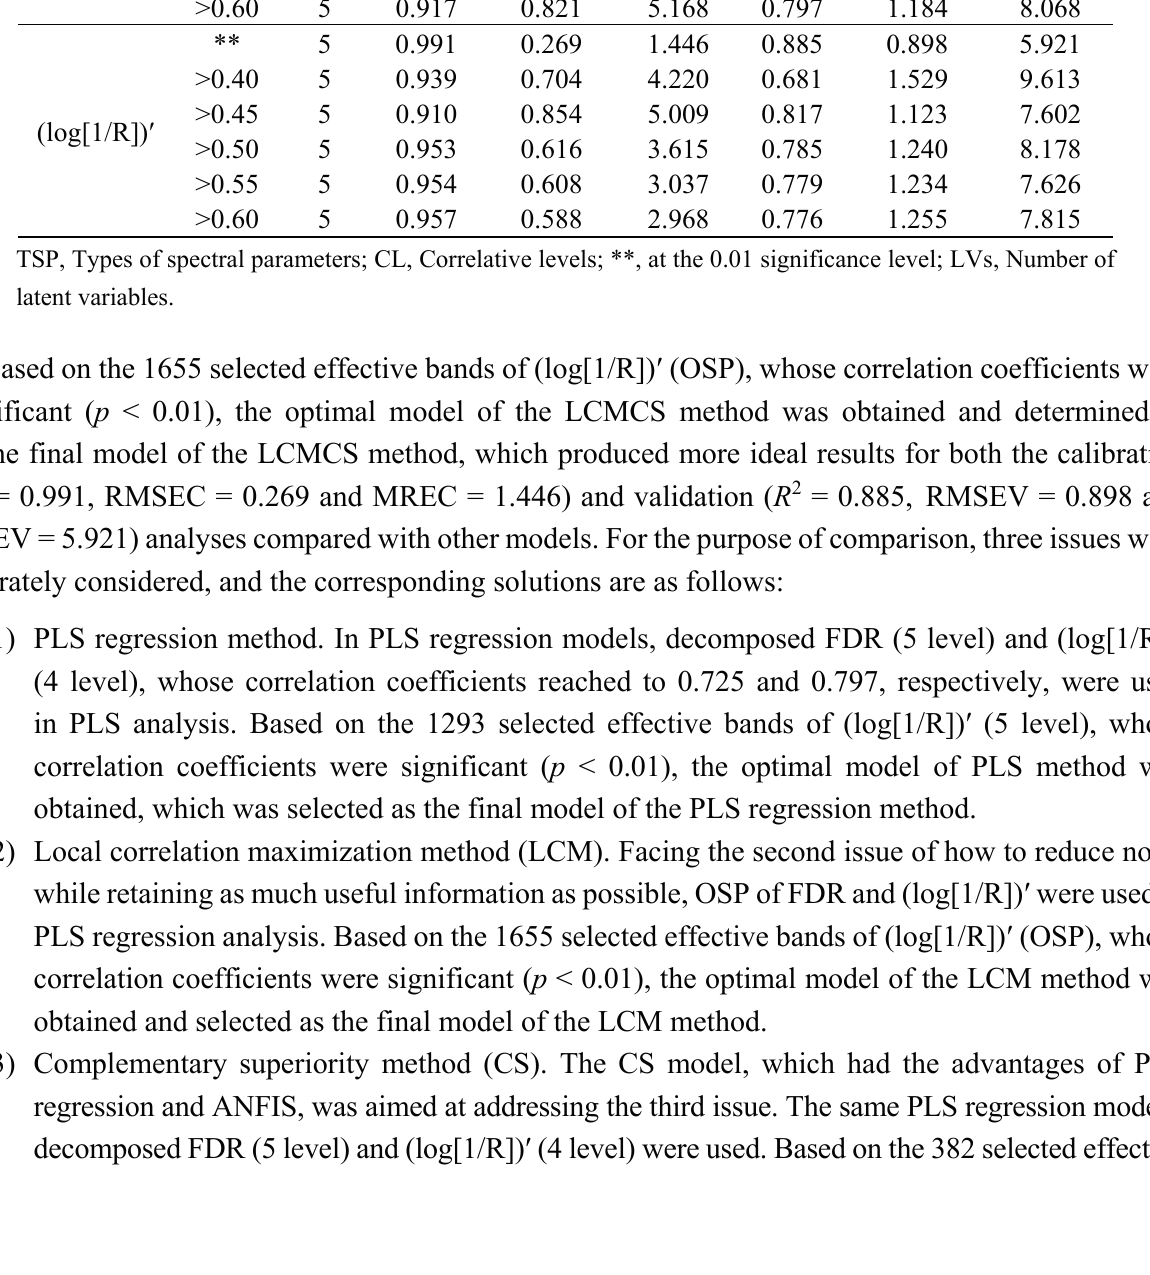
Table 6. Comparisons of the performance of models established by the local correlation maximization-complementary superiority method at different correlative levels of the first derivative differential (FDR (optimal spectrum [OSP]) and the first derivative differential of reciprocal logarithm (log[1/R]) ′ (OSP). Calibration ( n = 150) Validation ( n = 130) TSP CL LVs R 2 RMSEC MREC R 2 RMSEV ** FDR